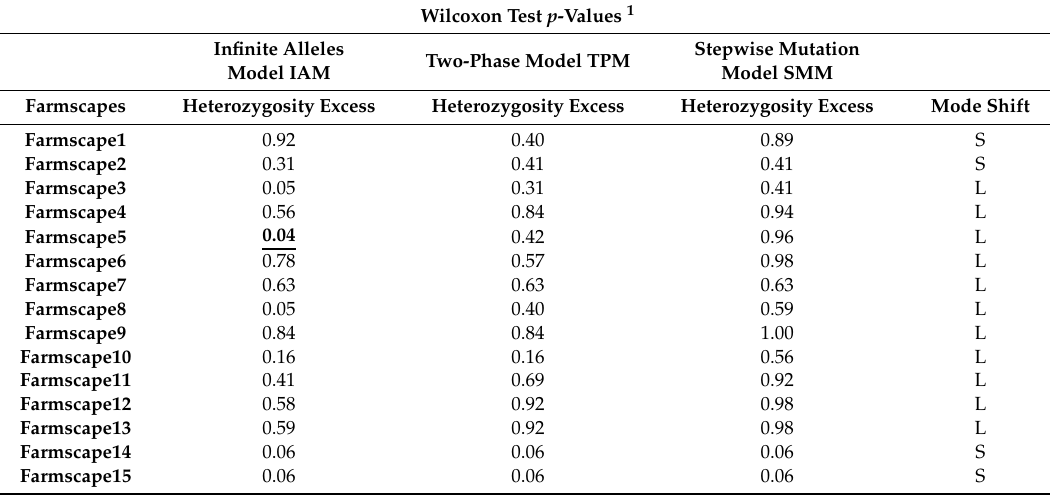
Table 6. Wilcoxon signed-rank test for mutation-drift equilibrium for 35 B. tabaci MEAM1 populations collected from di ff erent farmscapes, based on six microsatellite